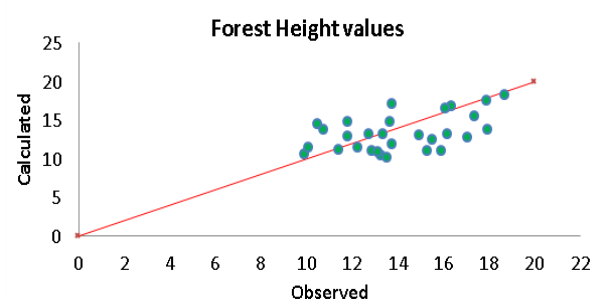
Figure 7: Regression line between the calculated and observed